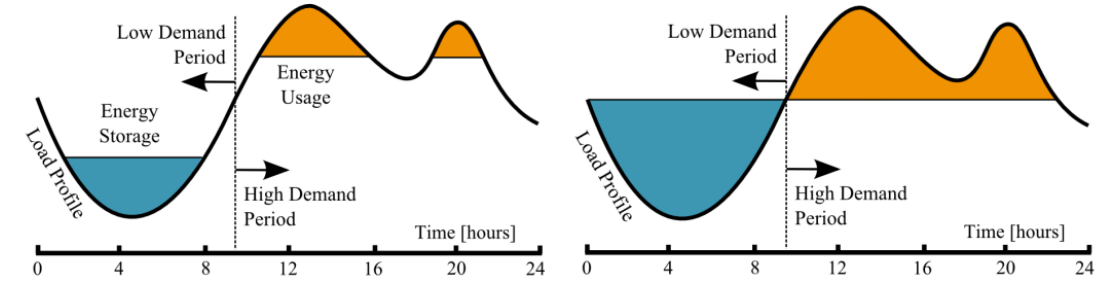
Figure 3. Consumer energy demands (load profile) over a 24 h period. The figure on the left shows a typical application of energy storage. While other intermediate applications exist, arguably, the ultimate goal of energy storage is load leveling as shown on the right. Figure modified from [4].